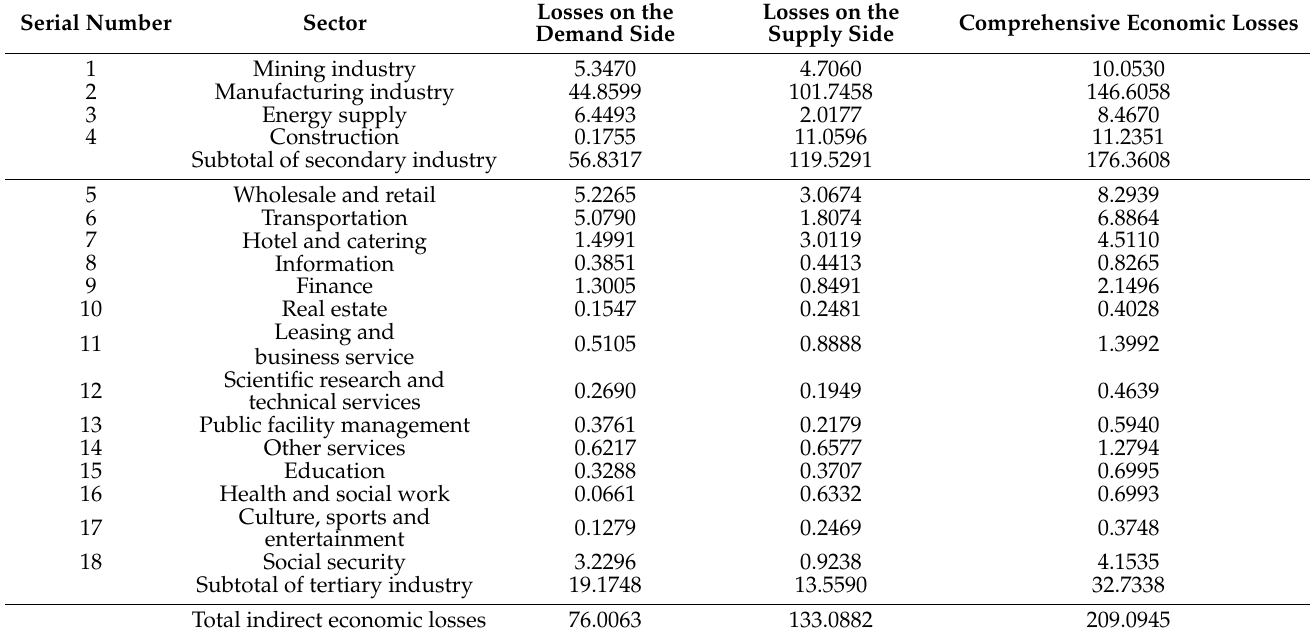
Table 2. Indirect economic losses of other sectors in Jiangxi province (unit: CNY 100